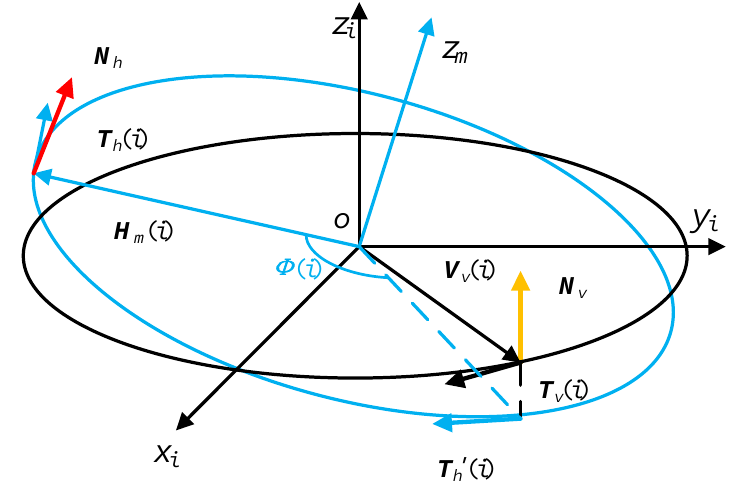
Figure 4. The diagrams of measured data and auxiliary data.